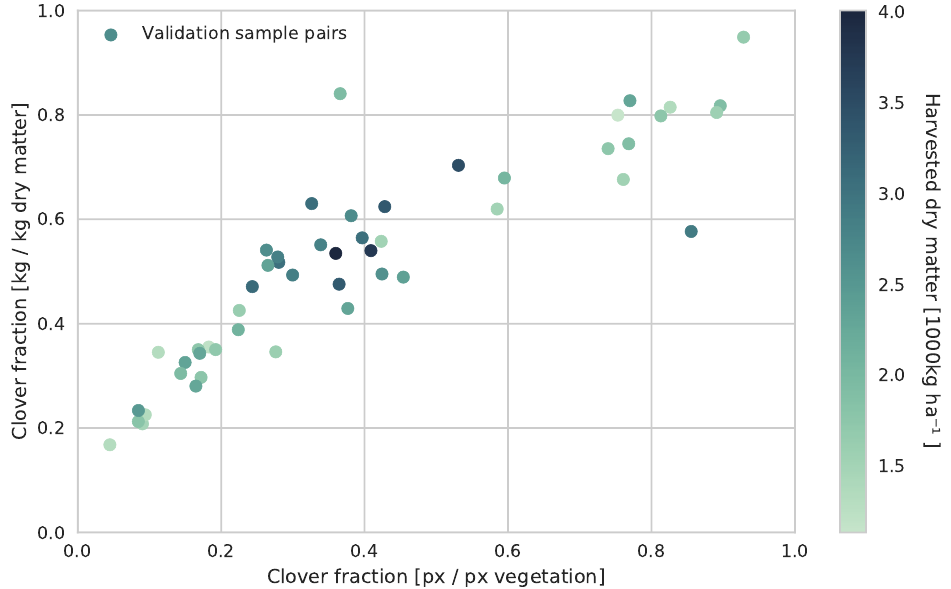
Figure 11. Comparison of the visual clover ratio and the dry matter clover ratio of the validation field site. The linear relationship is more poorly defined, with an introduction of a noticeable offset, possibly due to a less complete segmentation of clovers in the image